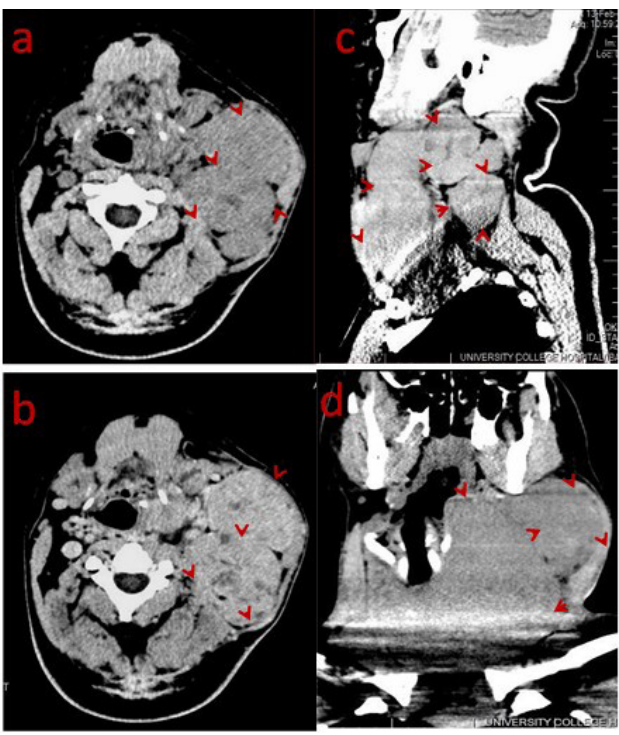
Fig. 1 - CT of the Head and Neck showing multiple enhancing round-oval shaped iso-dense masses with central hypo-densities consistent with enlarged cervical Lymph nodes (Red arrow heads) with necrotic centers in the antero- lateral and the left side of the neck demonstrated in a) Axial view in non-enhanced contrast NECT b) Axial view in contrast enhanced CECT c) Sagittal view CECT d) Coronal view CECT